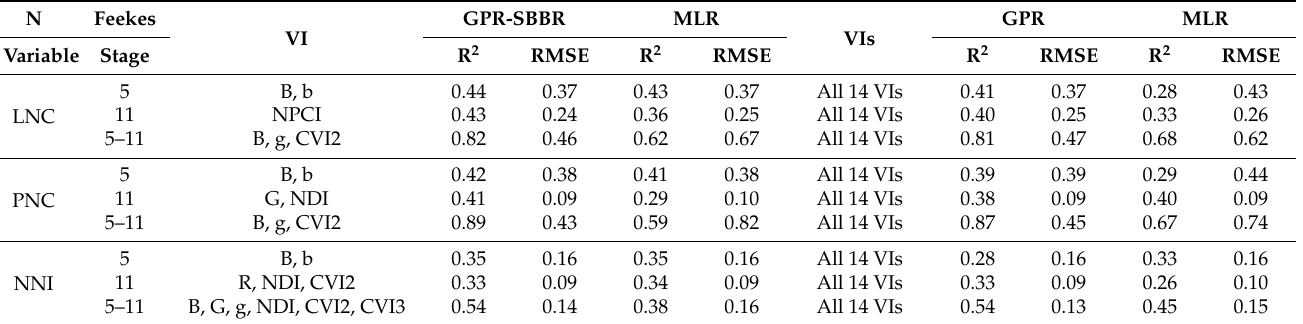
Table 8. Cross-validation results for N estimation through GPR and MLR based on UAV-mounted RGB camera